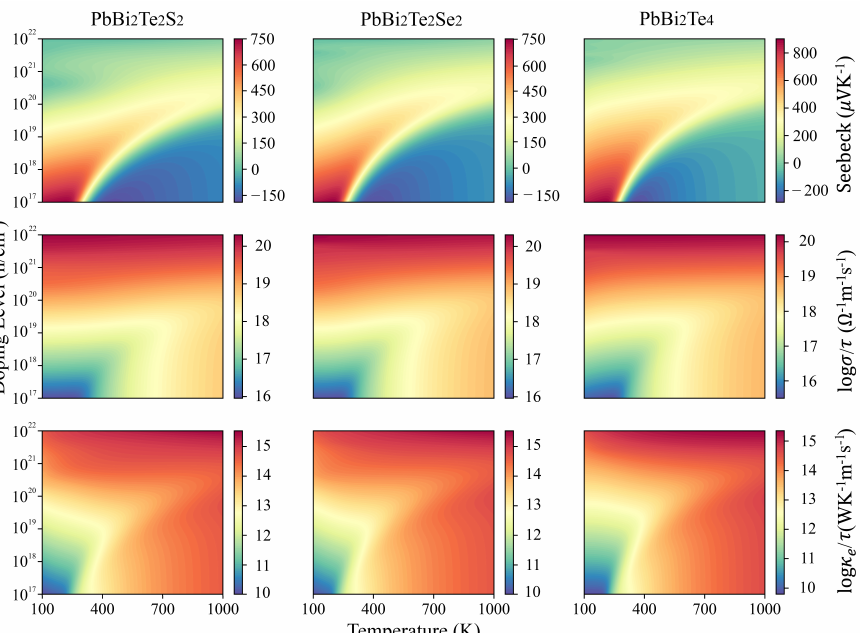
Figure 3. Calculated Seebeck coefficient and τ -scaled electrical and electronic thermal conductivities in the a-axis direction versus temperature and p-type doping levels for PbBi 2 Te 2 S 2 , PbBi 2 Te 2 Se 2 and PbBi 2 Te 4